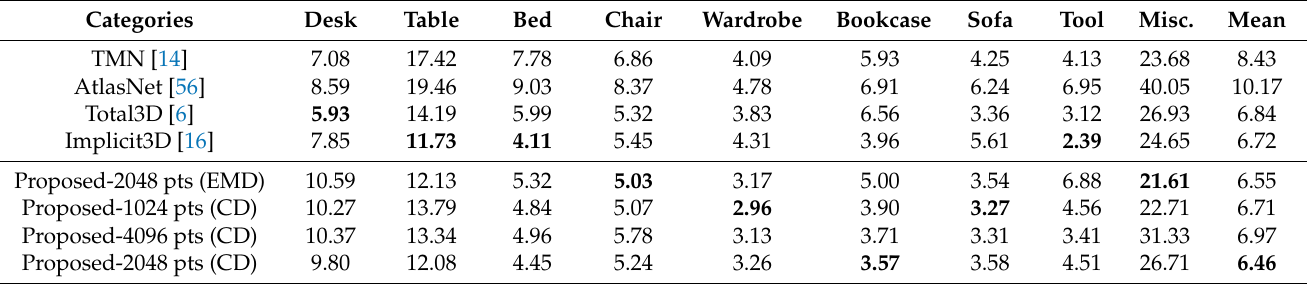
Table 3. Evaluation results of mesh reconstruction on the Pix3D dataset. The bolded results represent the highest scores.